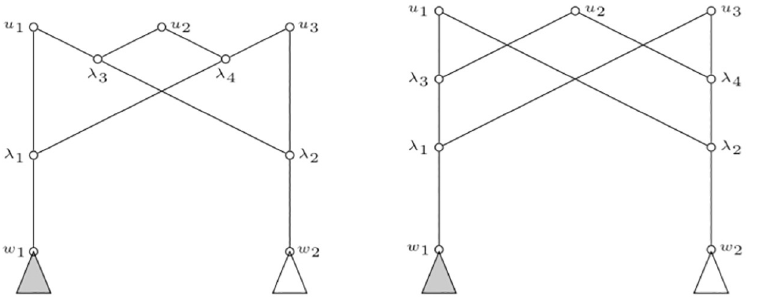
Fig 7. Non separable internally labelled phylogenetic networks. None of the nodes u 1 , u 2 , u 3 are separable. The filled and non-filled triangles pending from w 1 and w 2 represent non-isomorphic sub-networks.